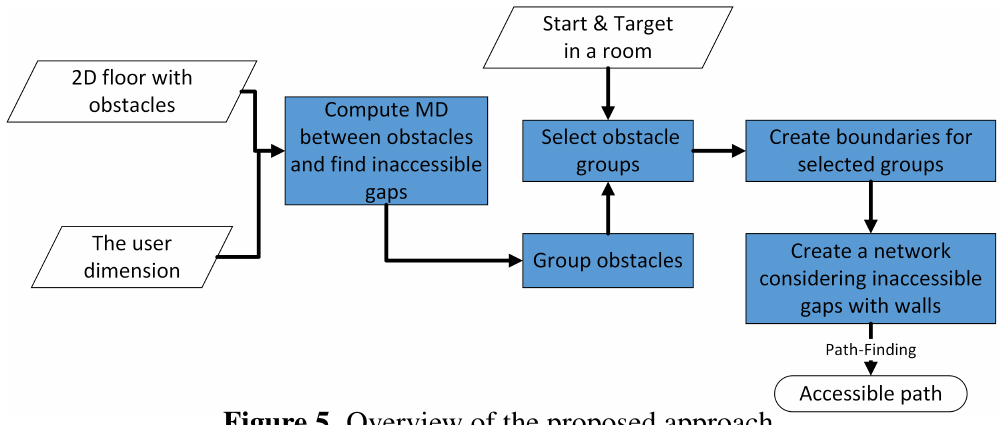
Figure 5. Overview of the proposed